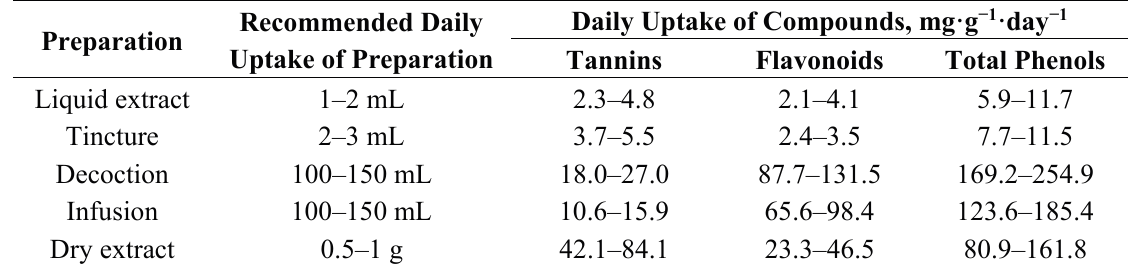
Table 9. Daily uptake of phenolic compounds after application of P. anserina preparations.